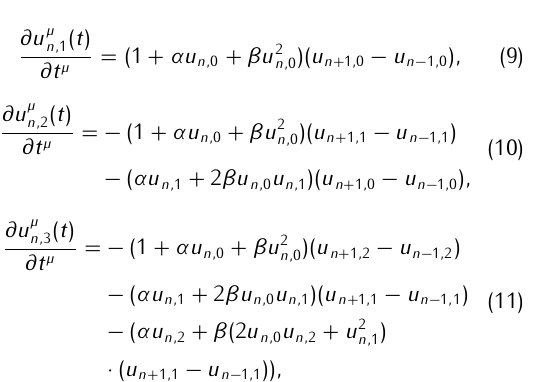
Figure 1. Explicit numerical solutions of Eq. (1) for u (15) at µ = 1 , λ = 1 . Redline µ = 1 , λ = 1 . Black line with c = 0 . 1 , d = 0 . 1 and t = 0 . 5 µ = 1 4 4